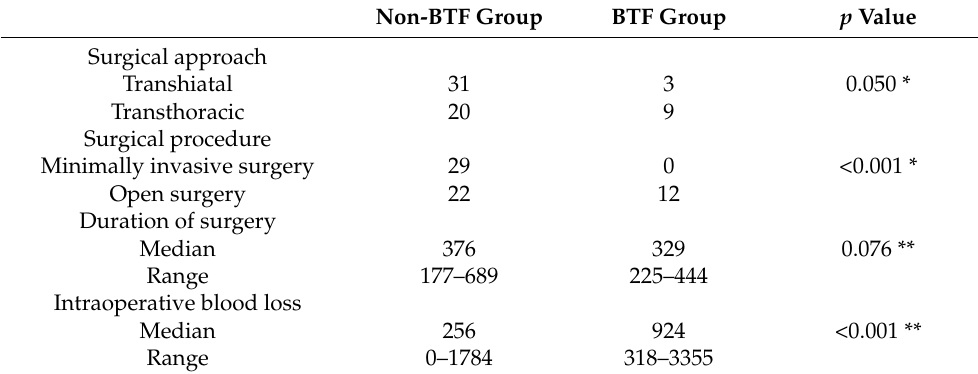
Table 2. Surgical findings.